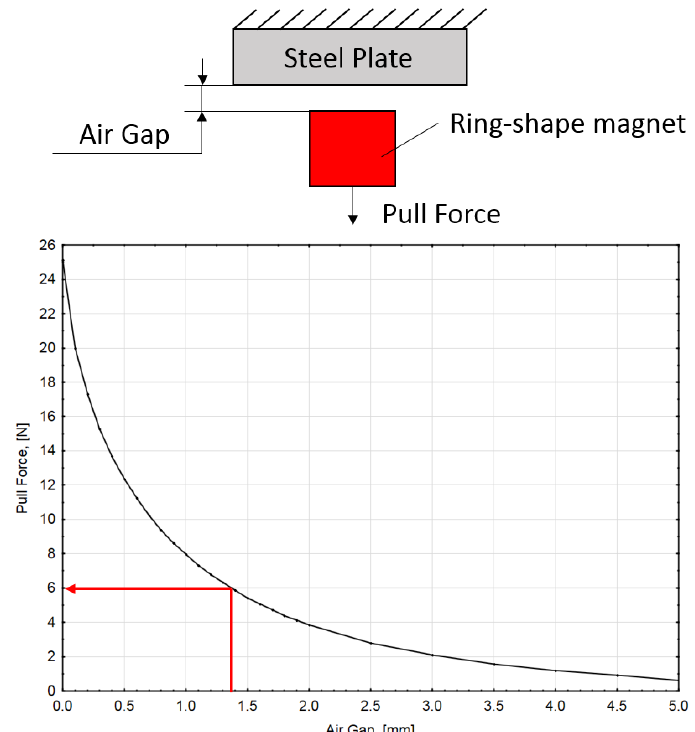
Figure 8. Magnet pulling force vs. distance. (Specified for the ring-shaped permanent magnet used in contact pair A.)